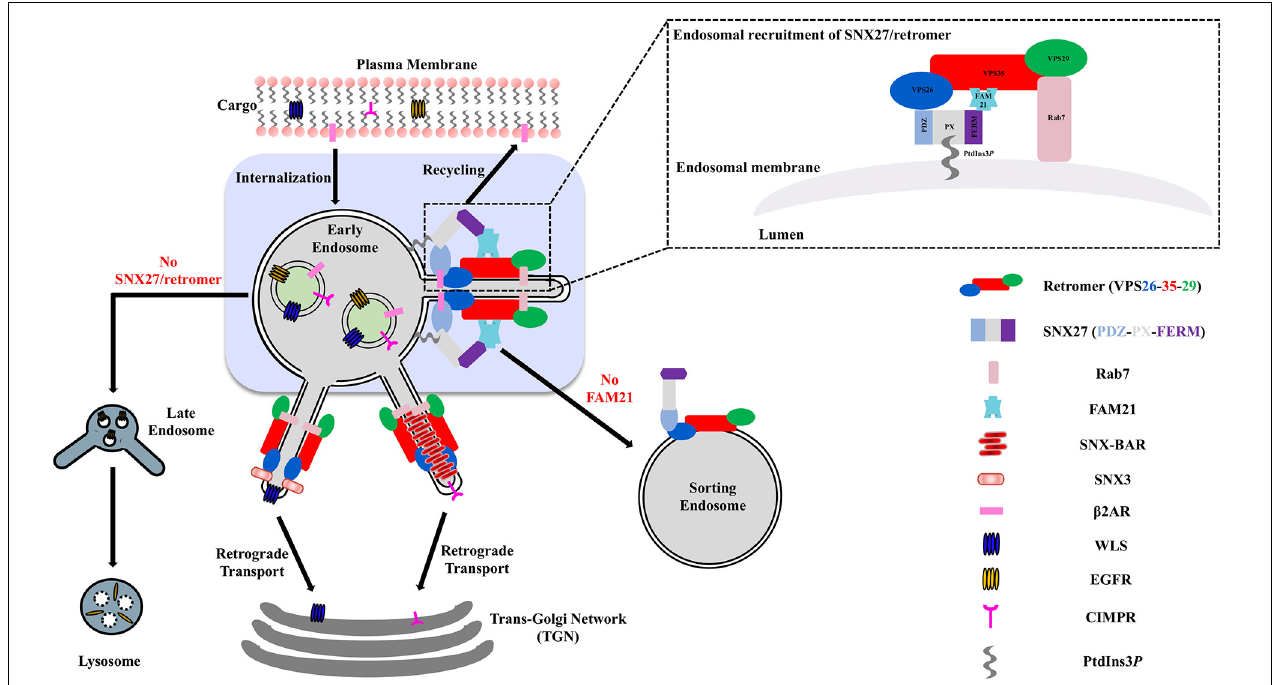
FIGURE 1 | Overview of SNX27/retromer pathway in metazoan cells. Metazoan retromer is implicated in three distinct endosomal pathways through direct interactions with SNX proteins to form elongated tubules. The SNX27/retromer pathway is specific to metazoans and mediates cargo recycling from endosomes to the plasma membrane. In this pathway, cargoes including β 2 adrenergic and glutamate receptors contain PDZ binding motifs recognized by SNX27. In addition, the SNX27 FERM domain binds NPxY motifs found in transmembrane cargoes. SNX-BAR/retromer and SNX3/retromer pathways occur in both yeast and metazoans. SNX-BAR/retromer retrieves cargoes from endosomes to the TGN, while SNX3/retromer is implicated in sorting receptors like Wntless (WLS) from endosomes to the